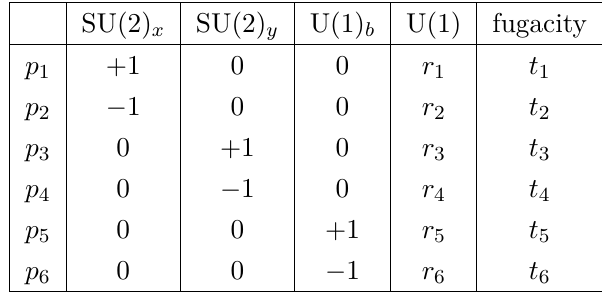
Table 43 . Global symmetry charges on the extremal brick matchings p i of Model